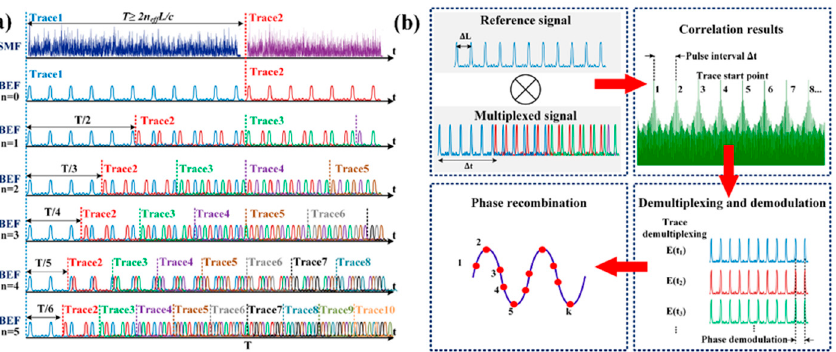
Figure 15. Time slot multiplexing scheme [74]: ( a ) principle; ( b ) demodulation algorithm.